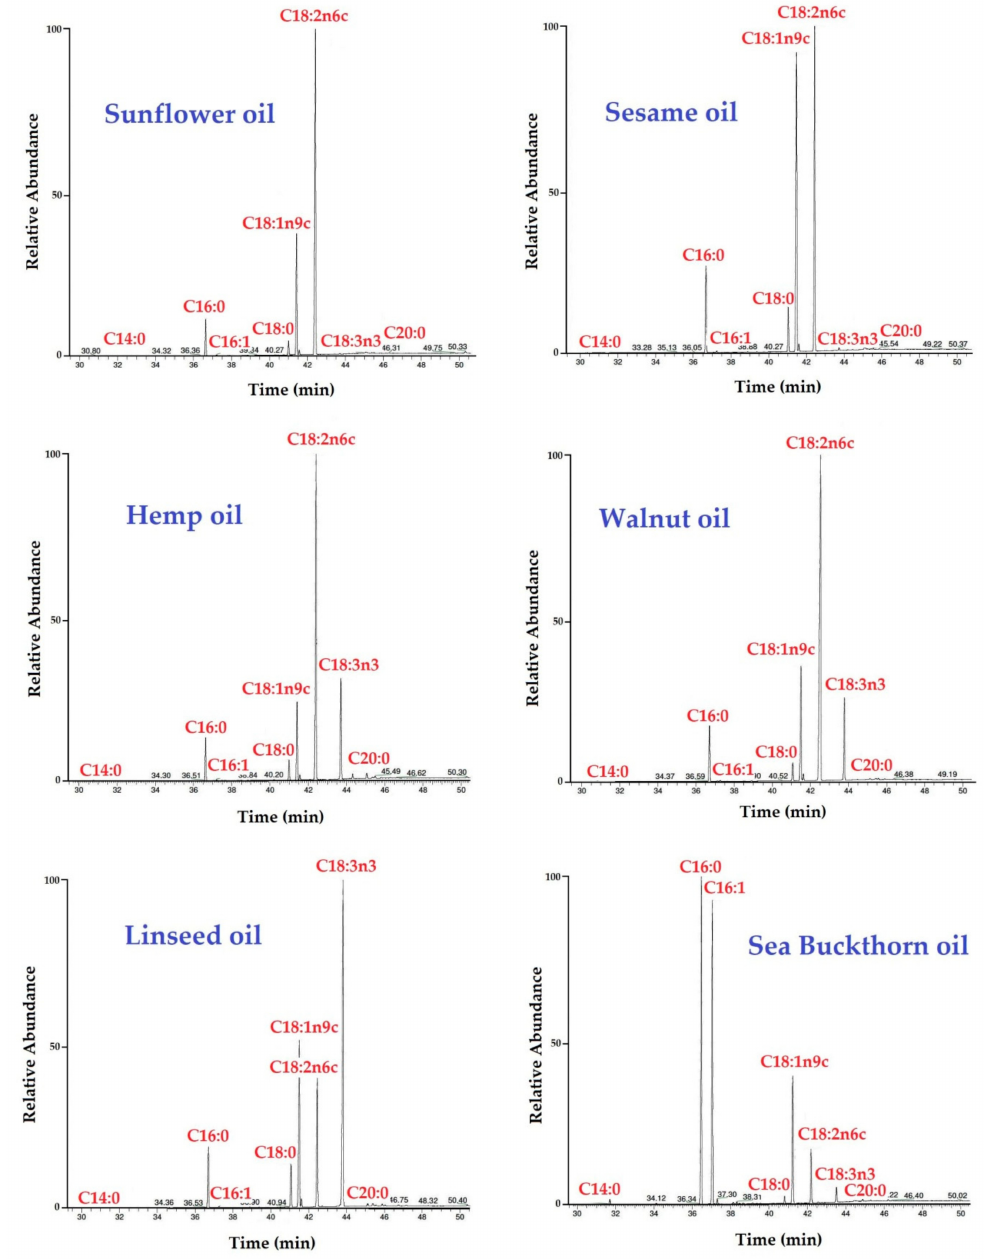
Figure 1. GC-FID chromatogram of oil samples with peak label. Peak label: C14:0—myristic